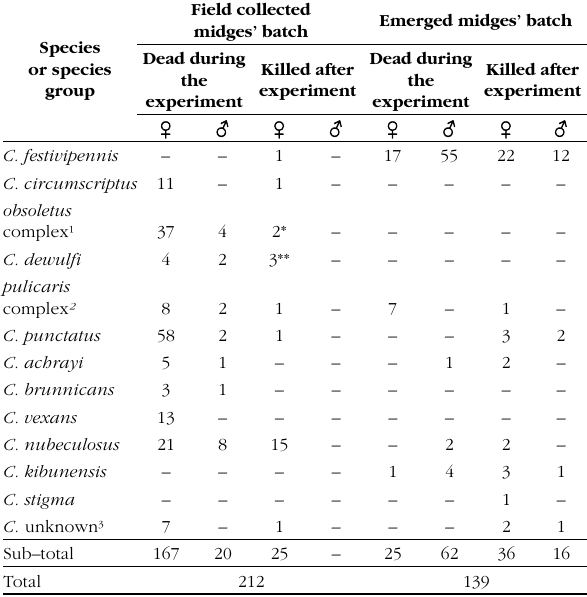
* two females belonging to this species group had a blood meal at 4 days p.i. one of them laid eggs and and was slightly positive for BtV antigen by qrt-PCr. ** two females belonging to this species group had a blood meal at 4 days p.i. ¹ the obsoletus complex includes c. obsoletus and c. scoticus females (males have all been identified as c. obsoletus ). ² the Pulicaris complex includes c. pulicaris and c. lupicaris . ³ Damaged individual not suitable for morphological identification. table – Sampling culicoides species collected inside the net cages after having spent 24 hours with a viraemic